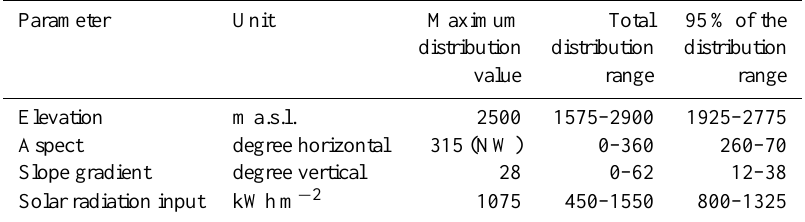
Figure 5. Frequency distribution of climate parameters for actual forest area (AFA: columns and left axes, in km 2 ) and the total study area (TSA: graph and right axes, in km 2 ). Table 2. Statistical values of the relief parameters related to the forest